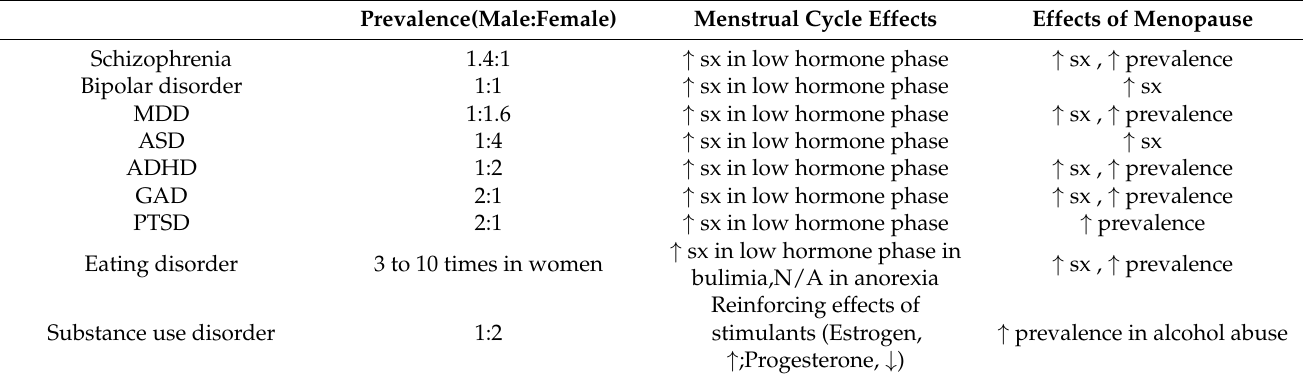
Table 1. Gender and hormonal effects across psychiatric illnesses. Prevalence(Male:Female) Menstrual Cycle